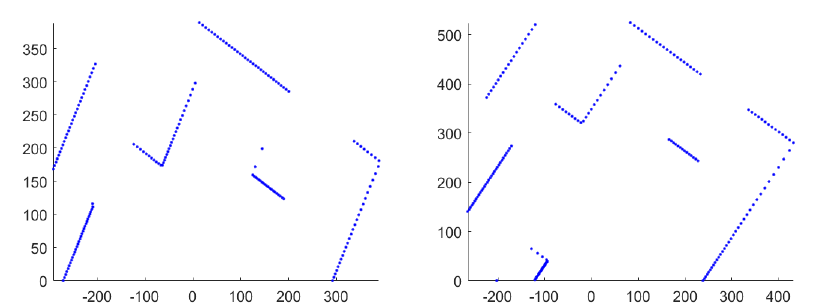
Figure 3. Visualization of laser range data for both real sensor RSD ( left ) and virtual sensor VSD ( right